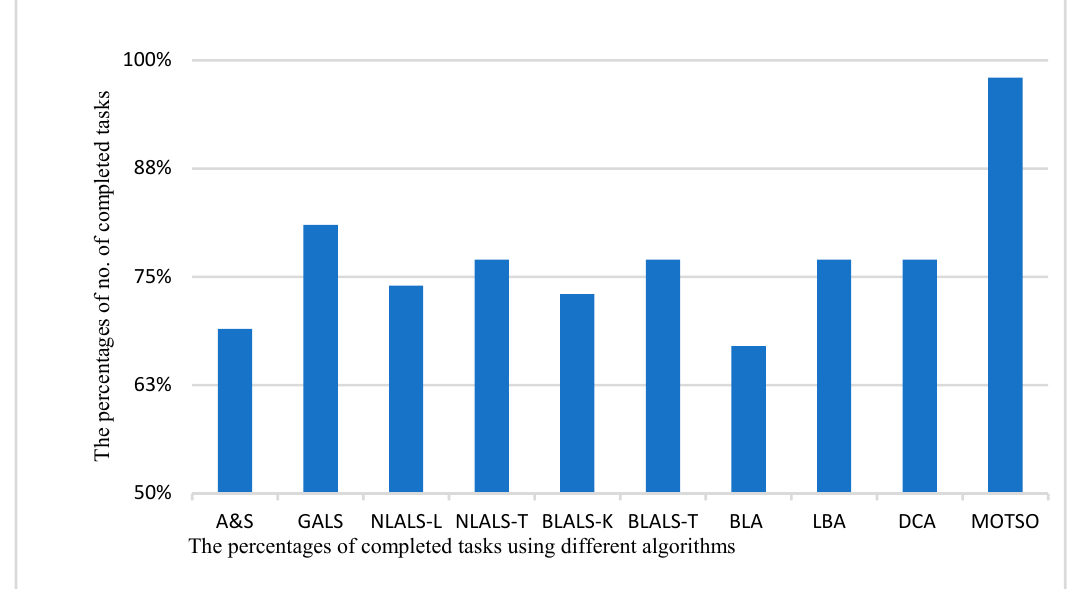
Figure 7. The percentage of completed tasks using different algorithms. A&S = baseline algorithm; GALS = global assignment and local scheduling algorithm; NLALA-L = naïve local assignment local scheduling based on location; NLALS- T = naïve local assignment local scheduling based on task-oriented partitioning; BLALS-K = bisection-based local assignment and local scheduling based on K-means; BLALS-T = bisection-based local assignment and local scheduling; BLA = baseline algorithm; LBA = load-balancing algorithm; DCA = divide-and-conquer